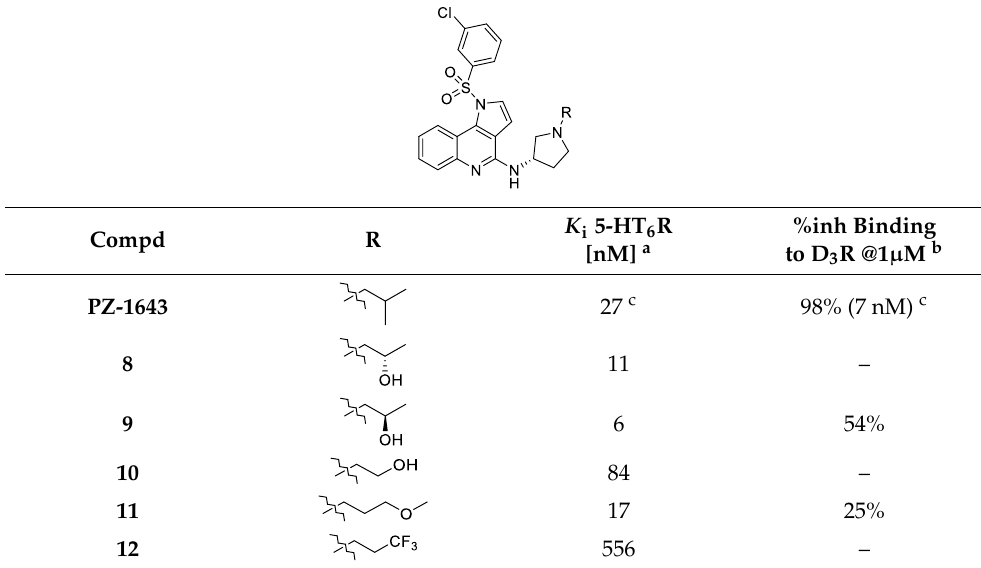
Table 1. Binding data of compounds 8 − 12 and reference compound PZ-1643 for 5-HT 6 and D 3 receptors.